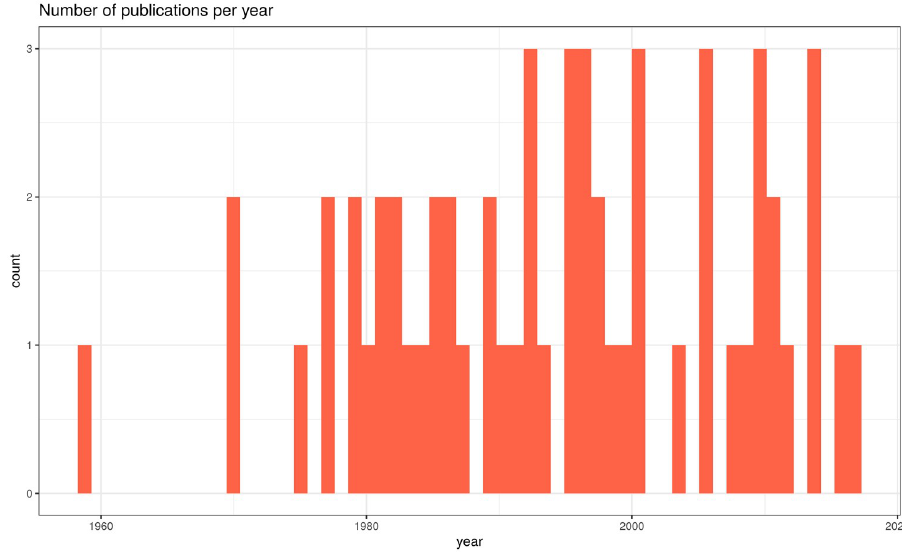
Fig 3. Number of publications per year, from 1959 to